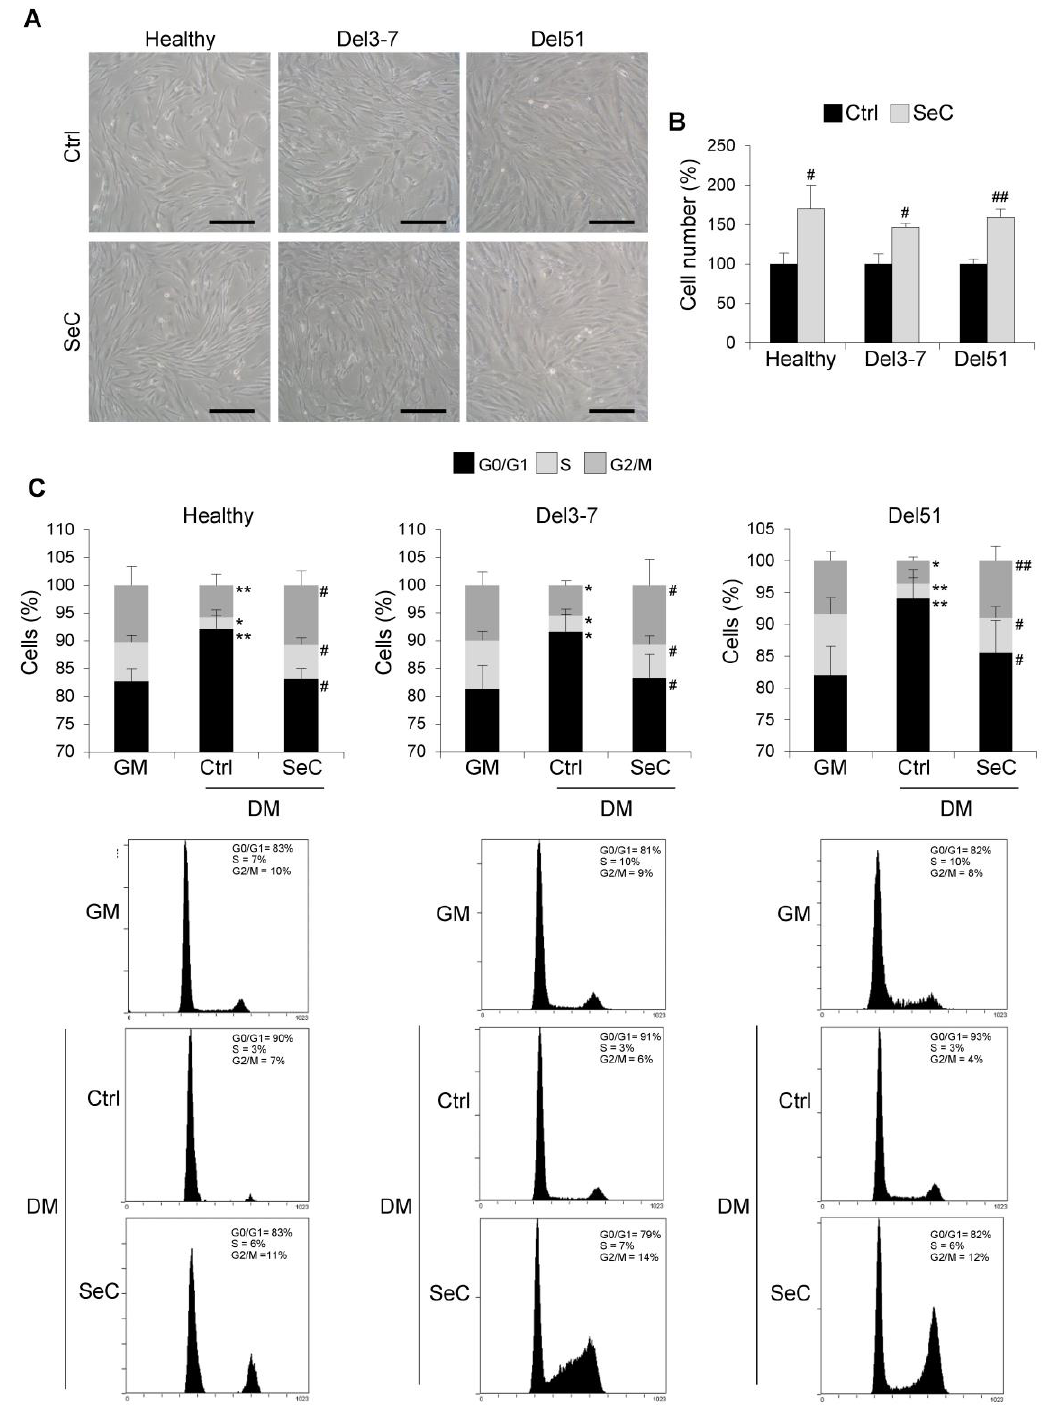
Figure 3. SeC promote cell proliferation in the early phase of the differentiation process in human healthy and DMD myoblasts. ( A – C ) Human myoblasts derived from healthy donor and DMD (Del3-7 and Del51) patients with different mutations were co-cultured in DM with or without freshly-isolated SeC (2.0 × 10 5 SeC/mL) using 0.4 µ m BD transwells, for 24 h. ( A ) Reported are representative phase contrast microscopy images. ( B ) Cell counts were performed to determine the percentage differences in cell numbers. ( C ) FACS analysis was performed to evaluate the percentages of cells in the different phases of the cell cycle in DM at 24 h in comparison with untreated cells cultured for 24 h in GM. Results are means of three independent experiments ( ± SD). * and **, significantly different from GM ( p < 0.05 and p < 0.01, respectively). # and ##, significantly different from Ctrl ( p < 0.05 and p < 0.01, respectively). Scale bars ( A ), 200 µm.